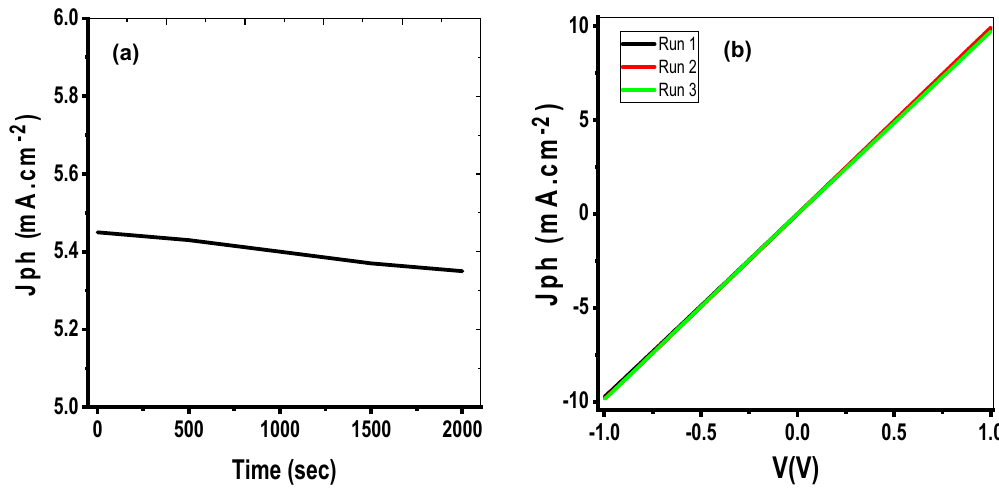
Figure 8. ( a ) The stability and ( b ) the reproducibility of PAOT/TiO 2 /TiN photodetector.